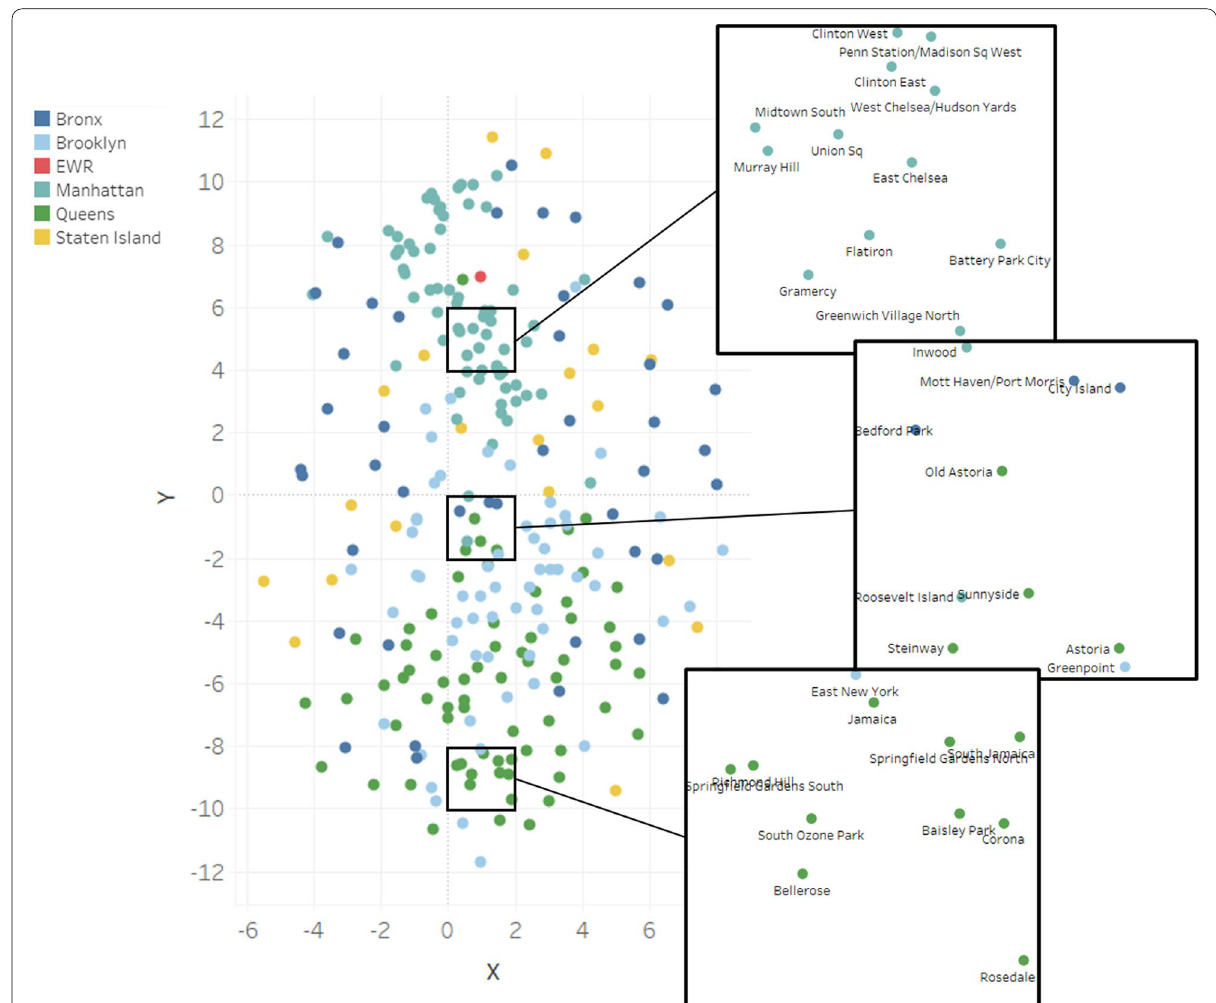
Fig. 5 Two-dimensional t-SNE reduction of the urban areas’ vector